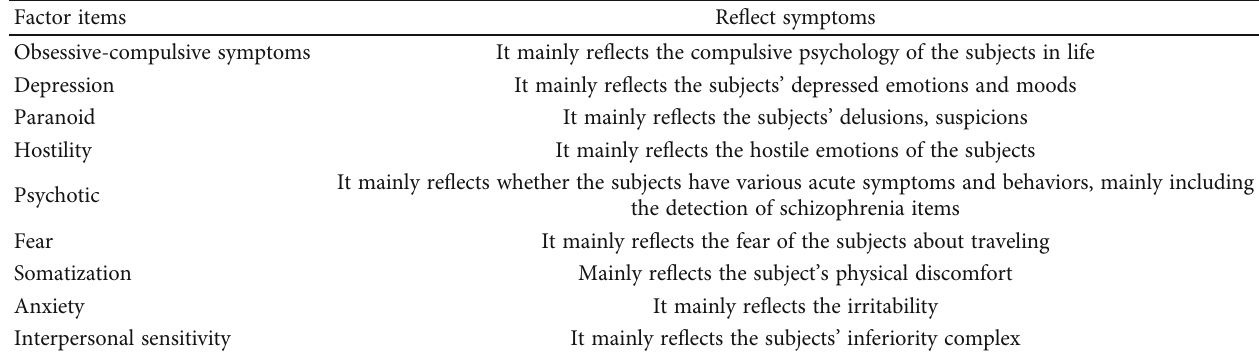
Table 1: Interpretation of each factor of SCL-90 symptom self-rating